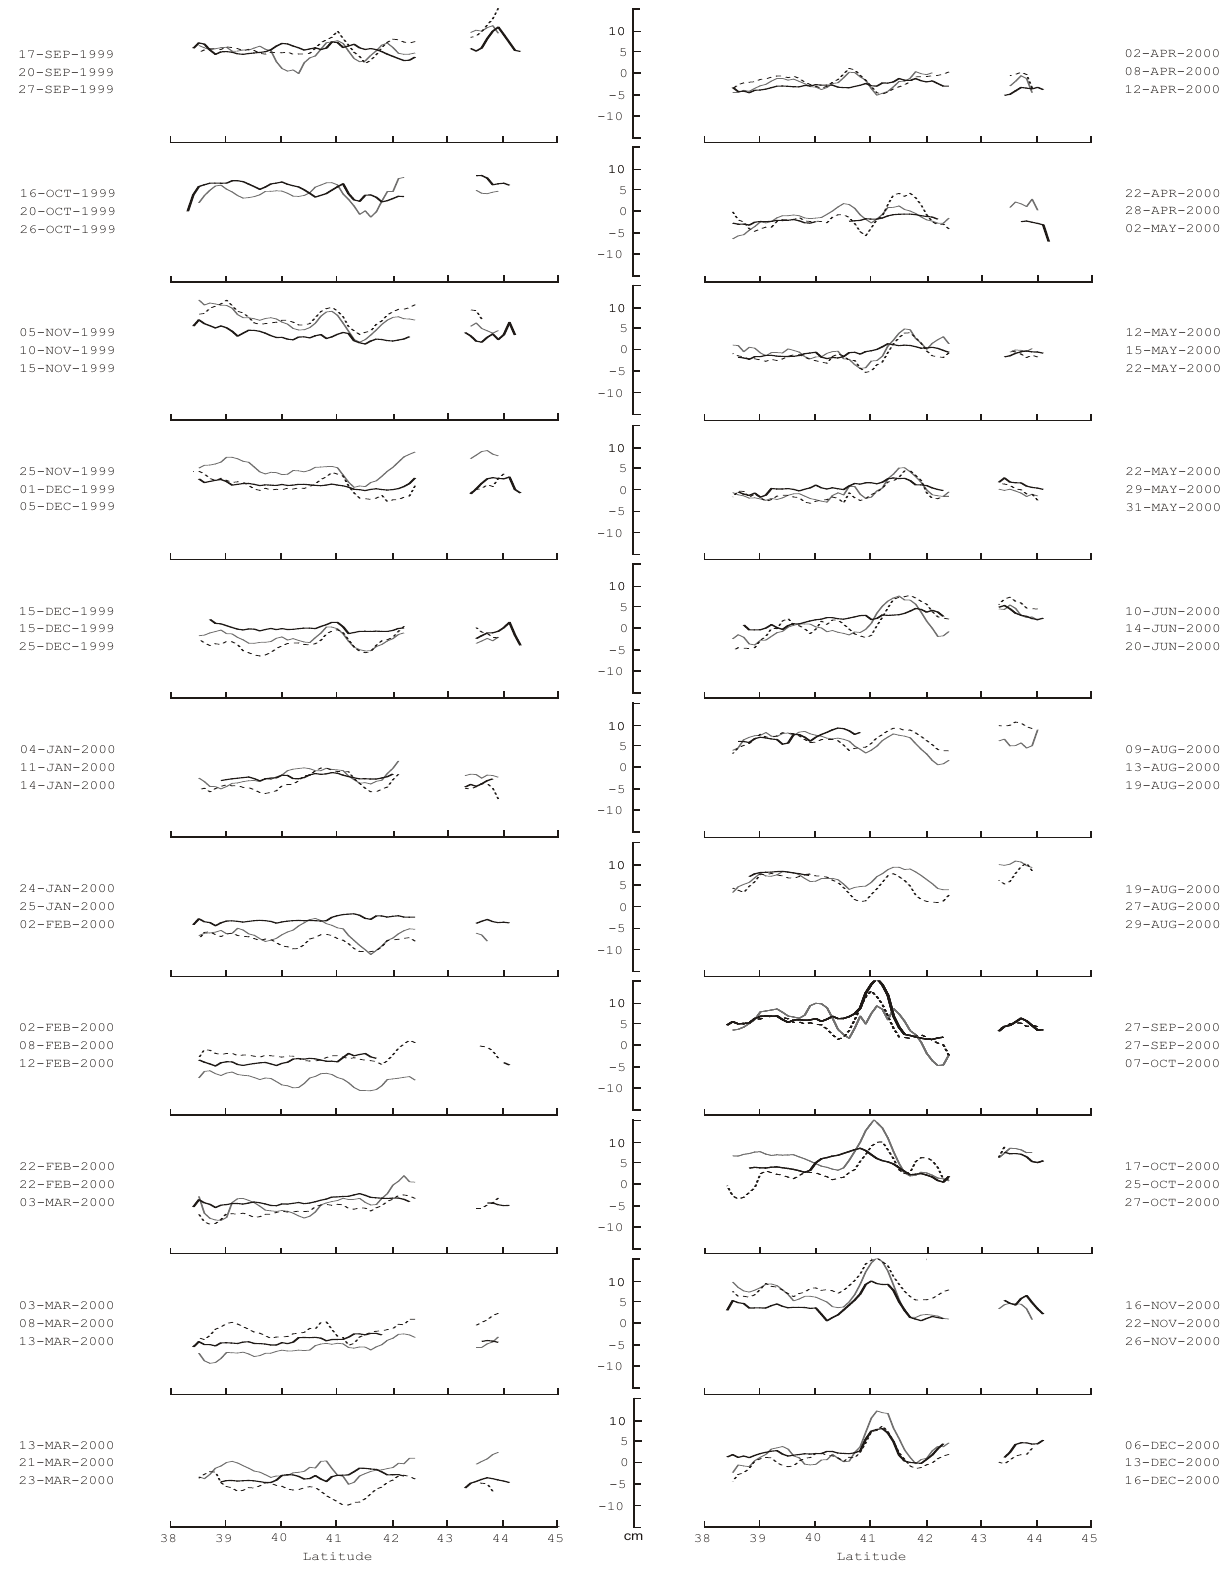
Fig. 6. XBT steric heights relative to 300m for the 22 cruises (tick solid line). Dashed (shaded) lines are the altimetric heights before (after) the time frame of the cruise. The horizontal axis is latitude